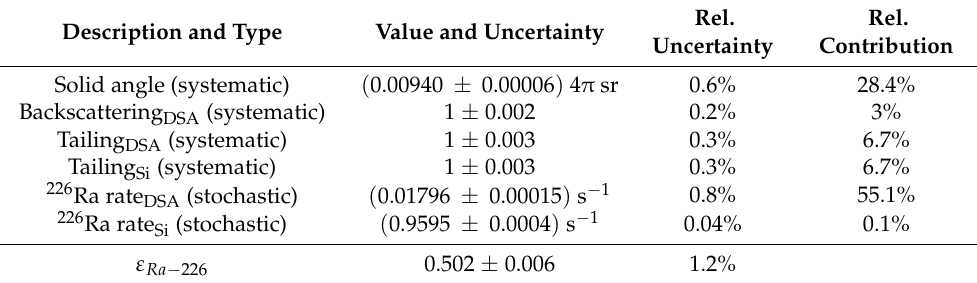
Table 2. Example uncertainty budget of efficiency determination of an IRSD of 2 Bq 226